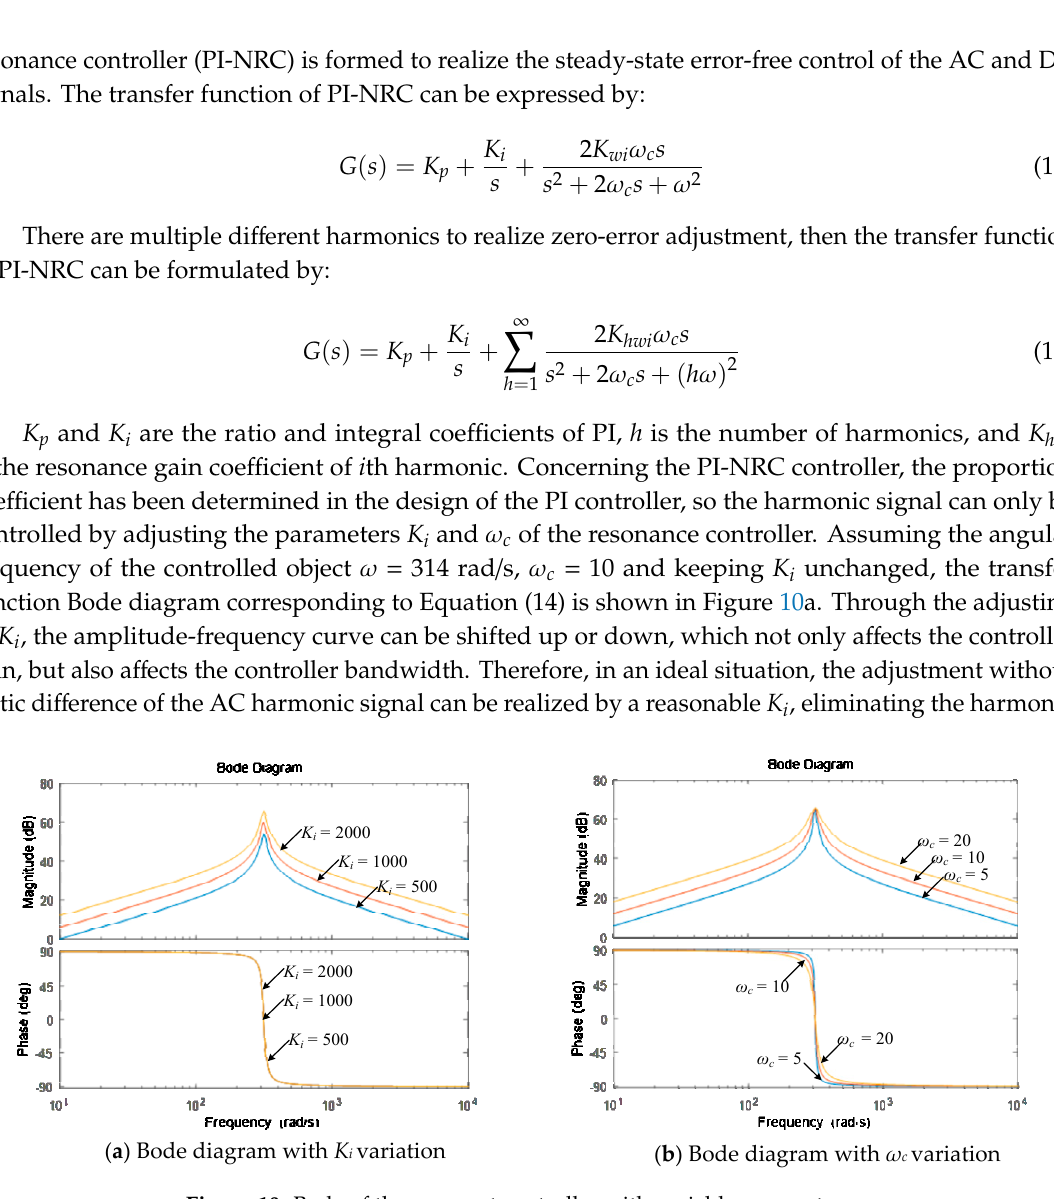
Figure 10. Bode of the resonant controller with variable parameters.